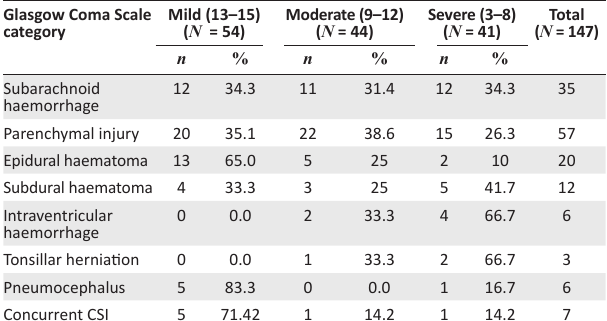
Mild (13–15) ( N = 54)